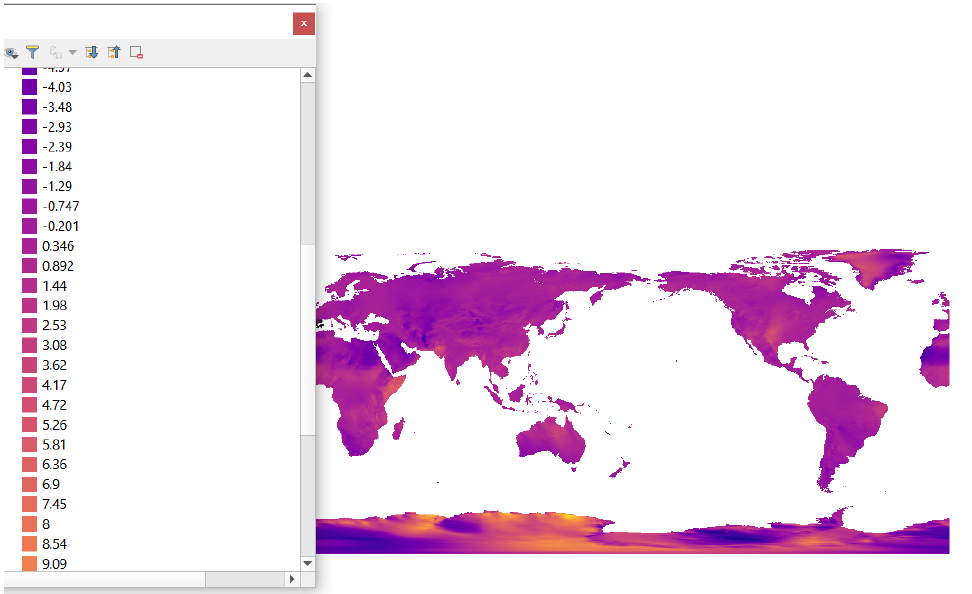
Figure 11. ECMWF: Wind speed (m/s) at 10 m v -component of wind. Own elaboration.